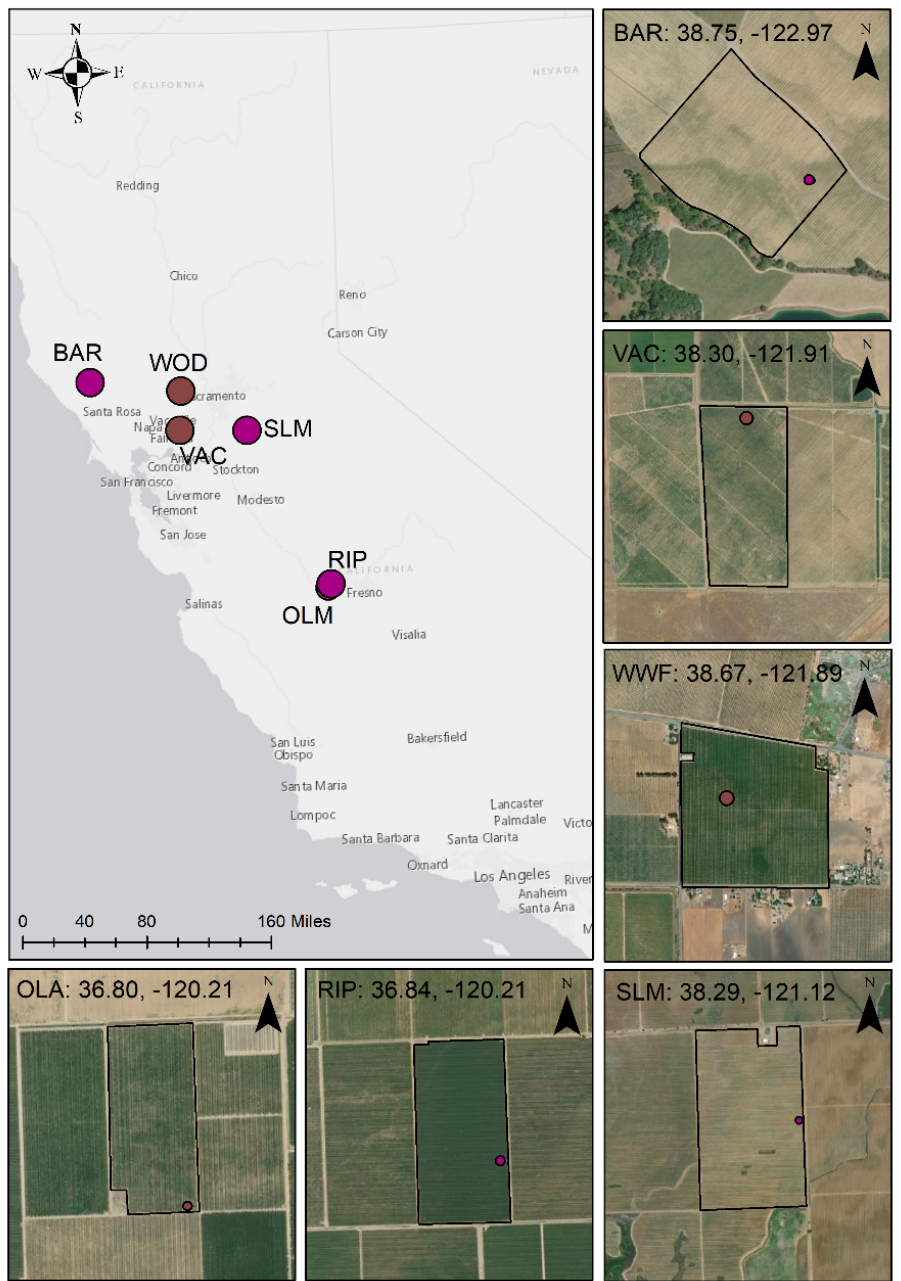
Figure 1. Locations of each wine grape vineyard (GRAPEX; purple) and almond orchard (T-REX; brown) under study. Black lines are the boundaries of the field and purple or brown dots are tower locations. The latitude and longitude of each tower location are given after the abbreviated site name.